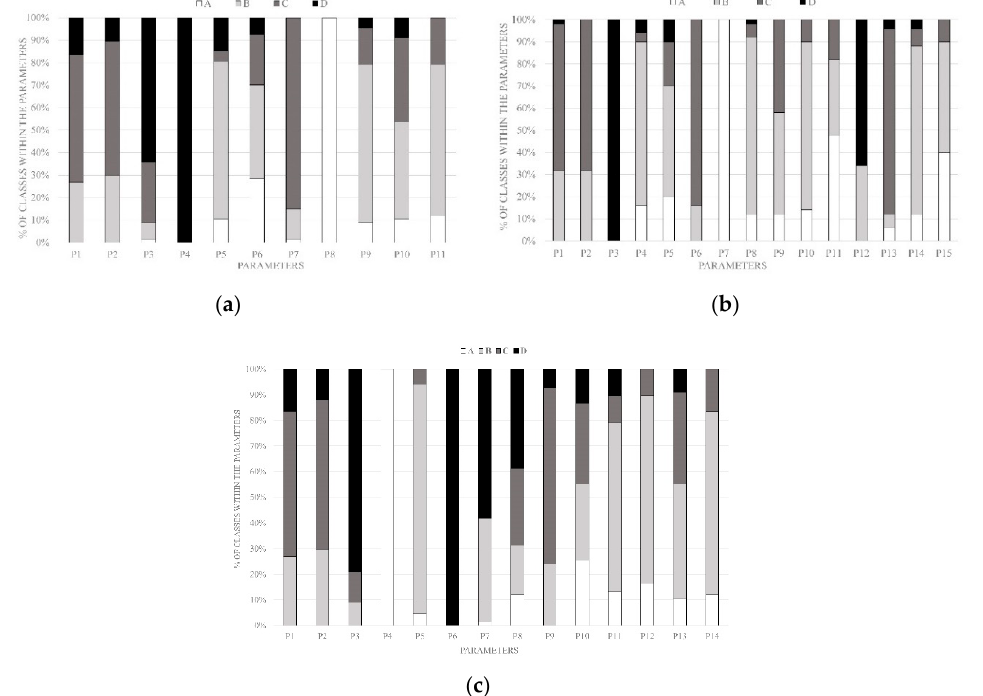
Figure 8. Vulnerability classes distribution of the different parameters, according to ( a ) the GDNT method, ( b ) the Formisano method and ( c ) the Vicente method.